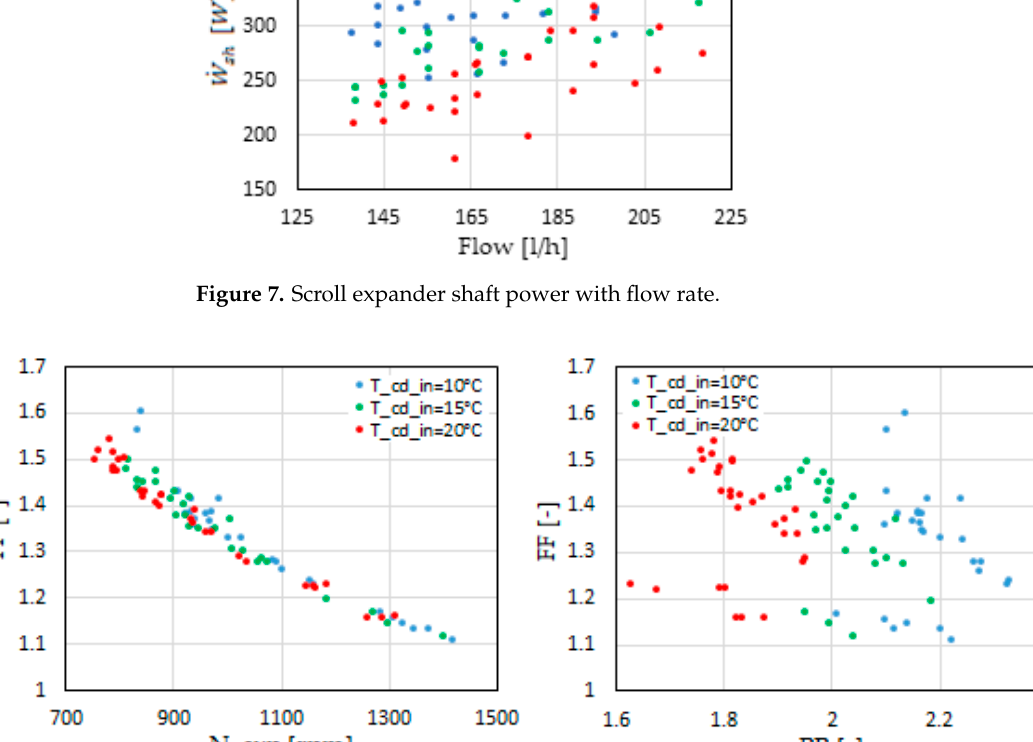
Figure 7. Scroll expander shaft power with flow rate.